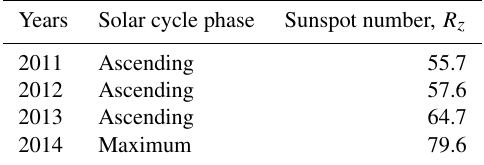
Table 1. Table of years, solar cycle phase and sunspot number, R z (source: